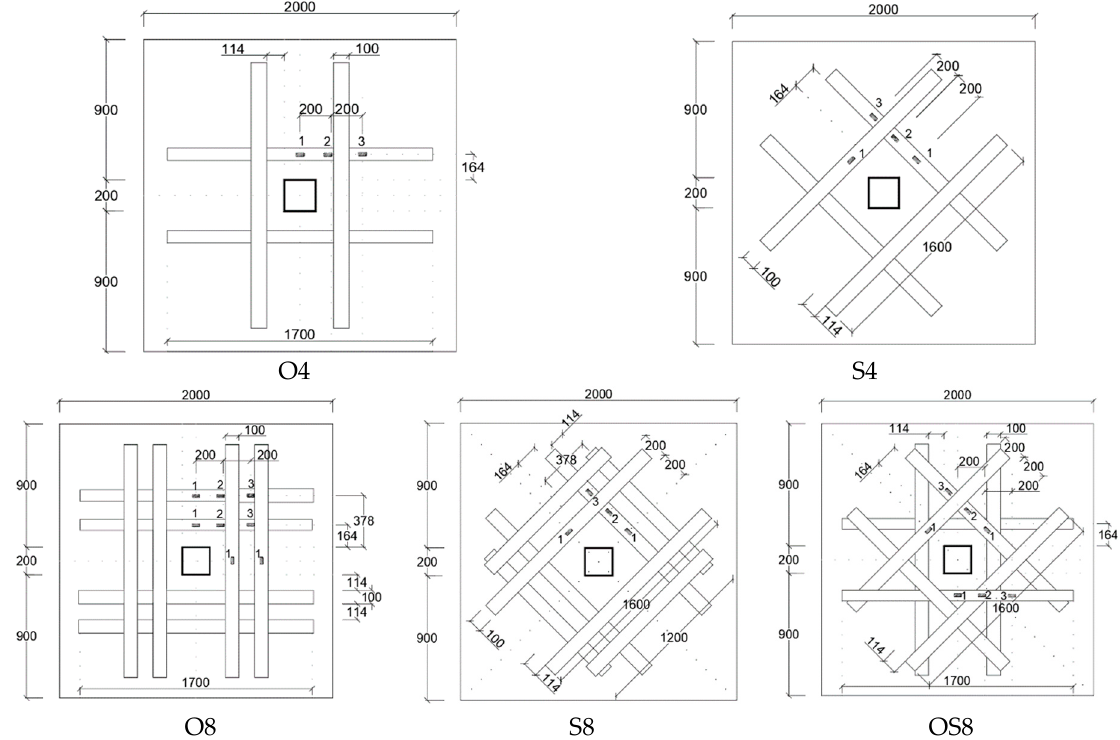
Figure5. CFRPstripsappliedtotensionsideorthogonaltocolumnorientation(O4andO8), skewedwith Figure 5. CFRP strips applied to tension side orthogonal to column orientation (O4 and O8), skewed with respect to column orientation (S4 and S8), or both orthogonal and skewed (OS8) [31].